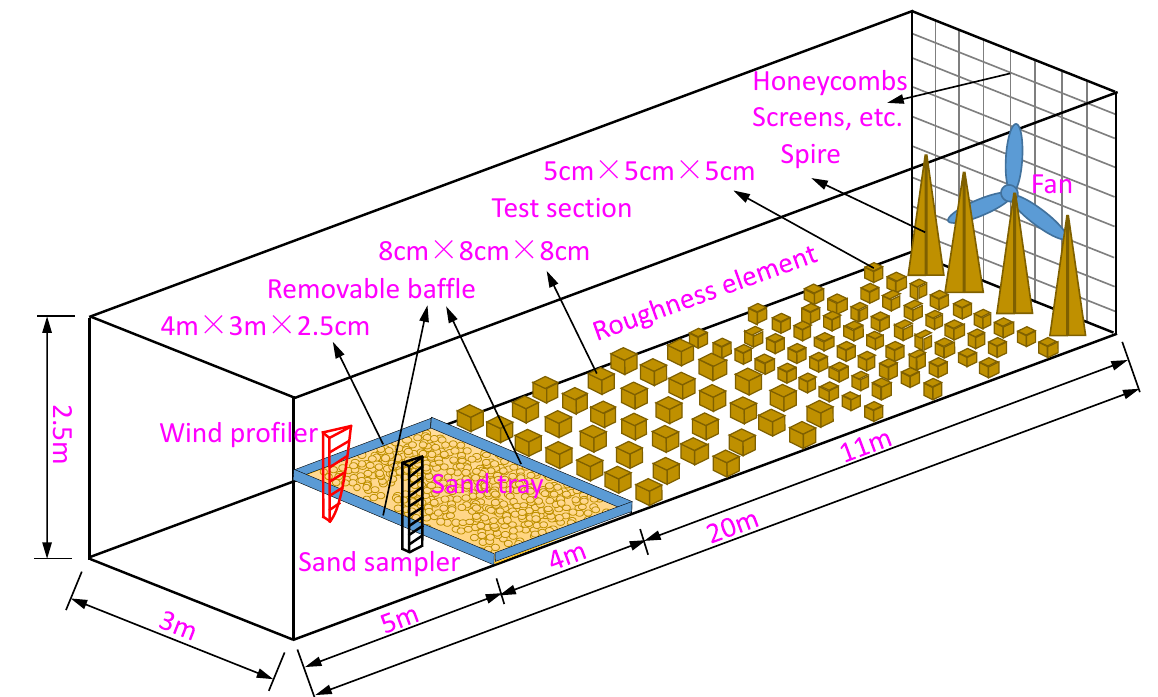
Figure 1. Windblown sand tunnel test section and wind field layout.